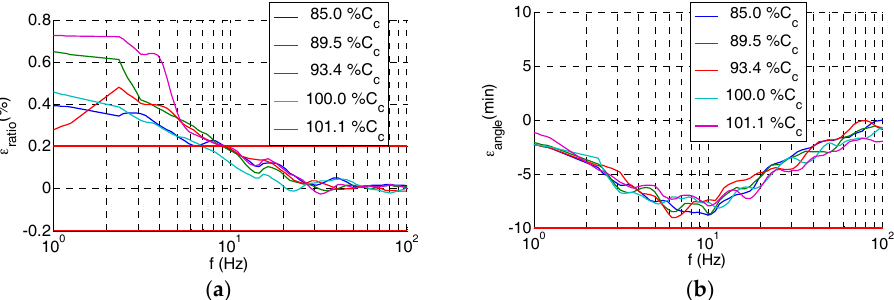
Figure 7. Measured errors of the built HV sensor in the low frequency range for difference lengths of the coaxial cable C c : ( a ) ratio error; ( b ) phase displacement error.